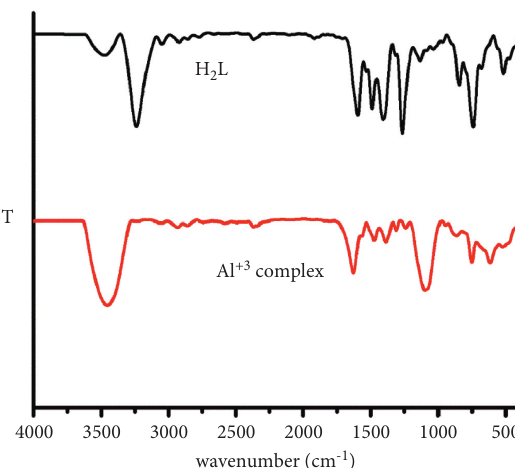
Figure 2: FTIR spectra of HL and its Al +3 complex.